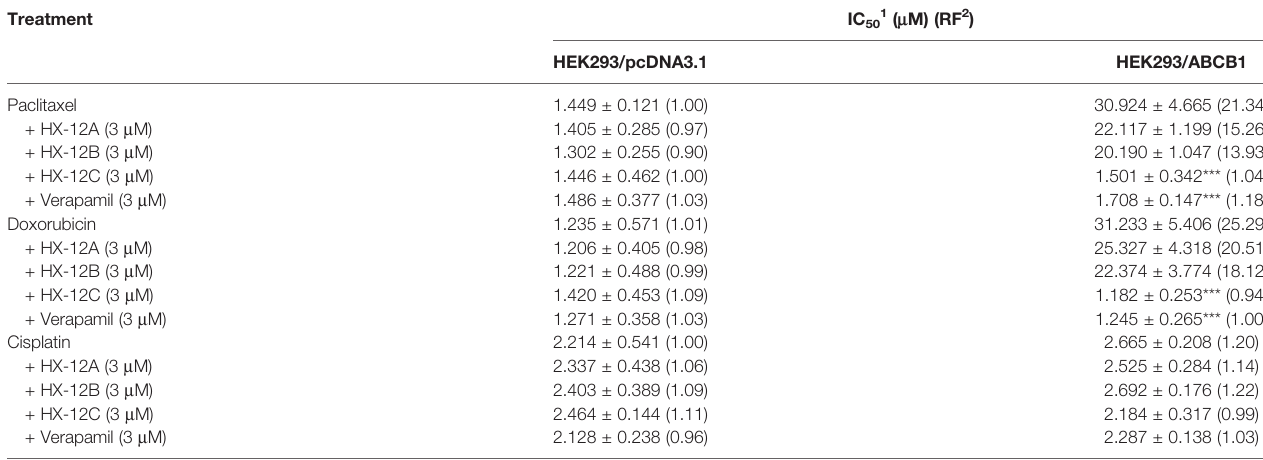
TABLE 2 | Reversal effect of three peptides on transfected ABCB1-overexpressing cells. Treatment